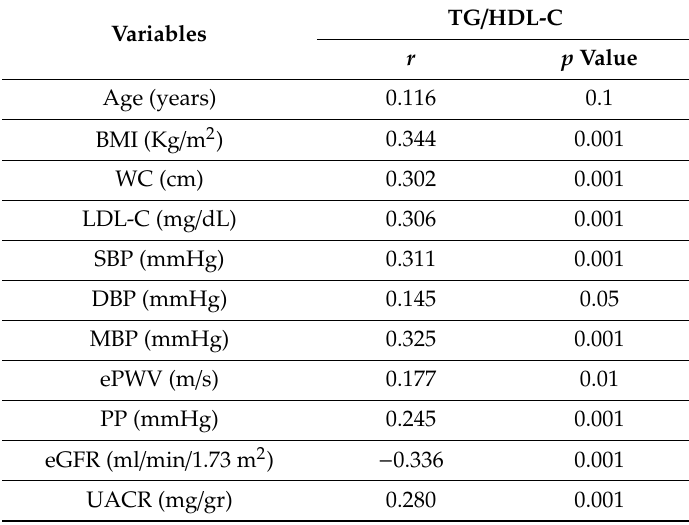
Table 2. Correlation of TG / HDL-C ratio with di ff erent studied variables in our data ( n = 183). Variables